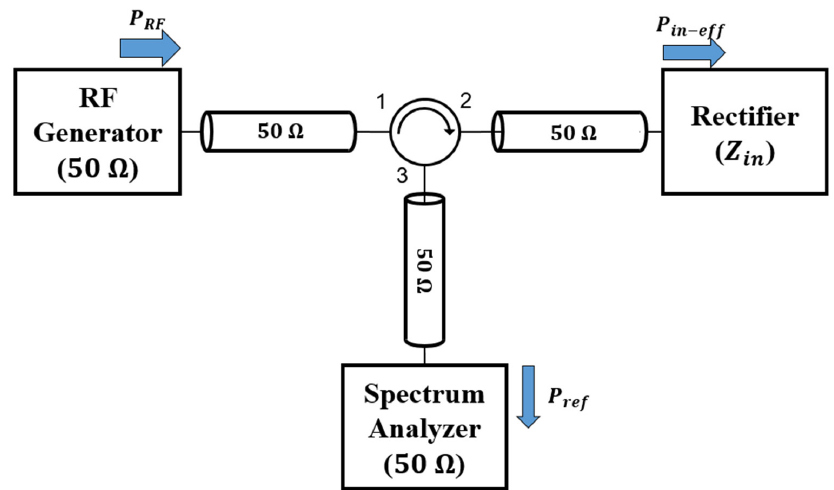
Figure 19. Block diagram of measurement system.